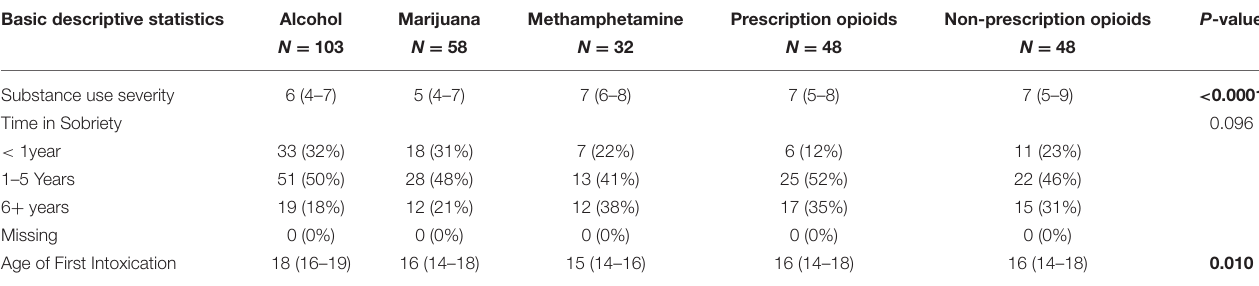
TABLE 2 | Substance use history and characteristics of the subsample of participants with a history of problematic substance use ( N = 289). Basic descriptive